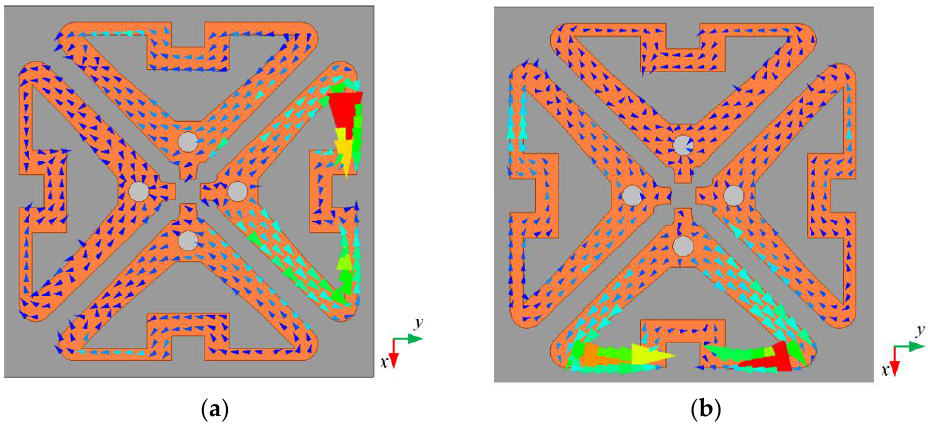
Figure 5. Current distributions of the proposed antenna fed by ( a ) Port 1 and ( b ) Port 2.